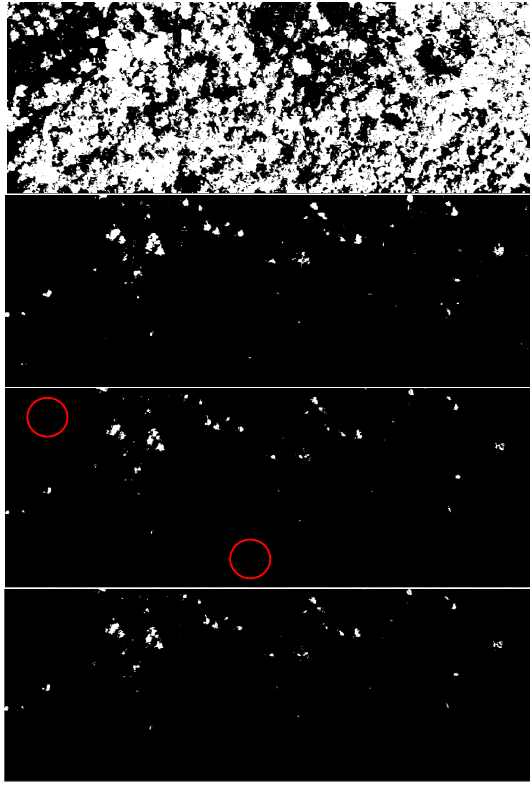
Figure 5. Comparison of four threshold segmentation results in RGI grayscale image (from top to bottom: Otsu method, Kittler method, Bernsen method and Niblack